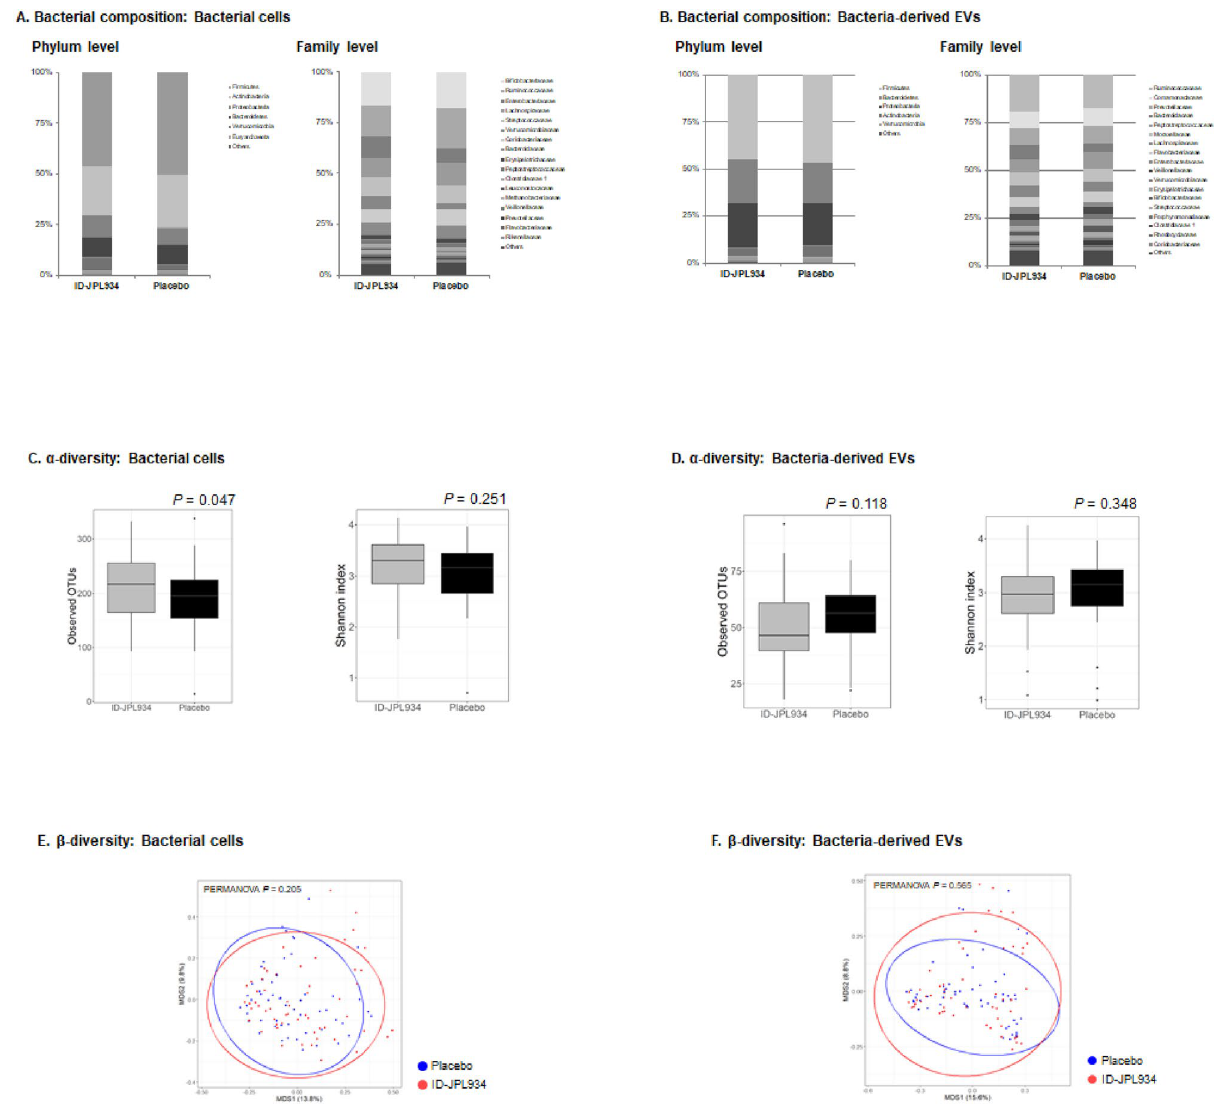
Figure 4. Summary of metagenomic analyses of the ID-JPL934 group and the placebo group at week 8. The compositions of bacterial cells ( A ) and bacteria-derived EVs ( B ) in feces of the ID-JPL934 group and the placebo group at 8 weeks is comparable. The microbial diversity of bacterial cells was decreased in ID-JPL93 group compared with the placebo group based on observed OTU counts ( p = 0.047) but not according to Shannon index ( C ). The microbial diversity of bacteria-derived EVs was not different between the two groups ( D ). In bacterial cells ( E ) and bacteria-derived EVs ( F ), no significant differences in β-diversity index were observed between the two groups (PERMANOVA p > 0.05, Bray–Curtis